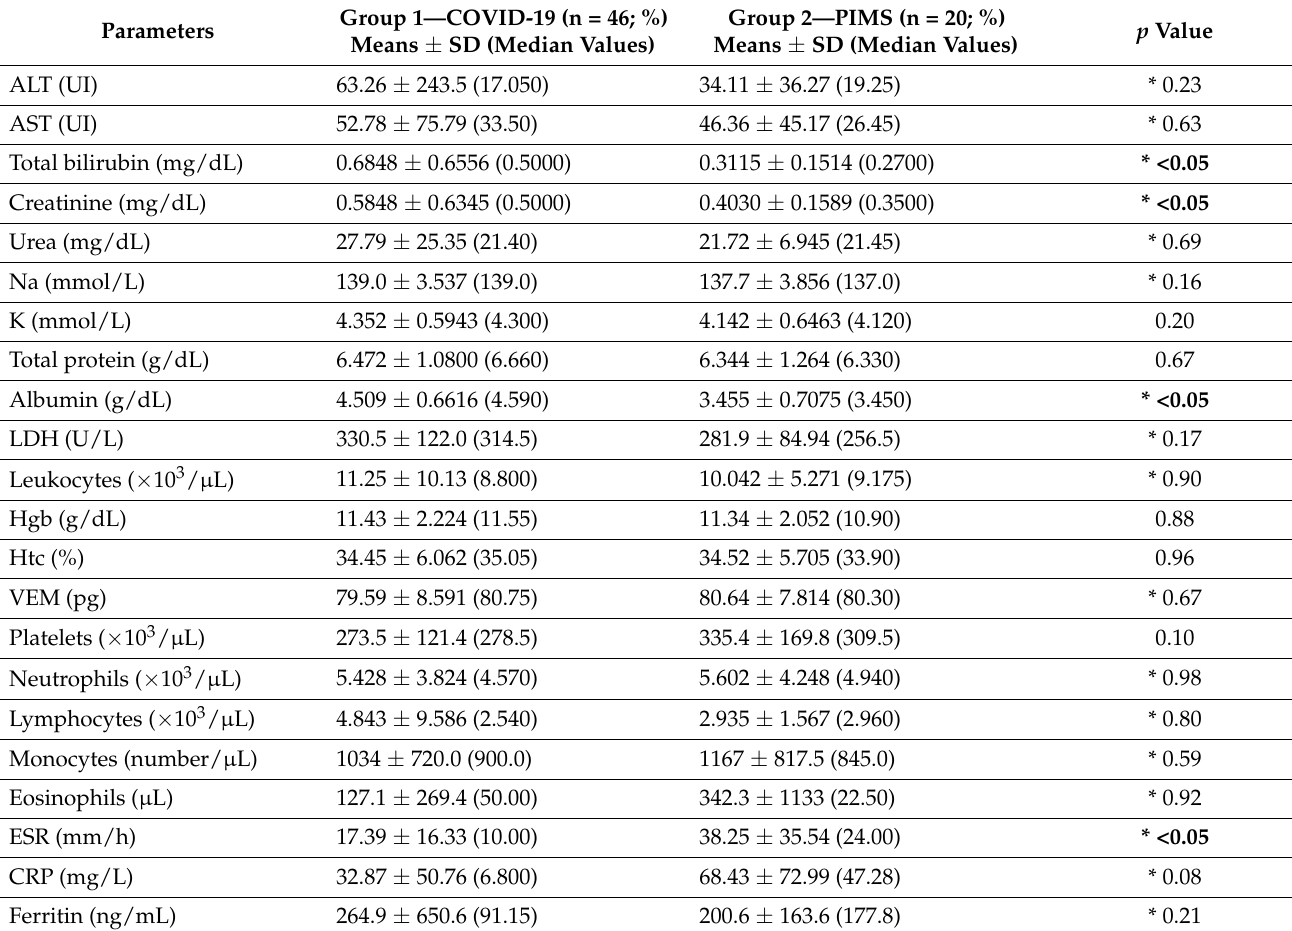
Table 3. The assessment of hematological and biochemical parameters.